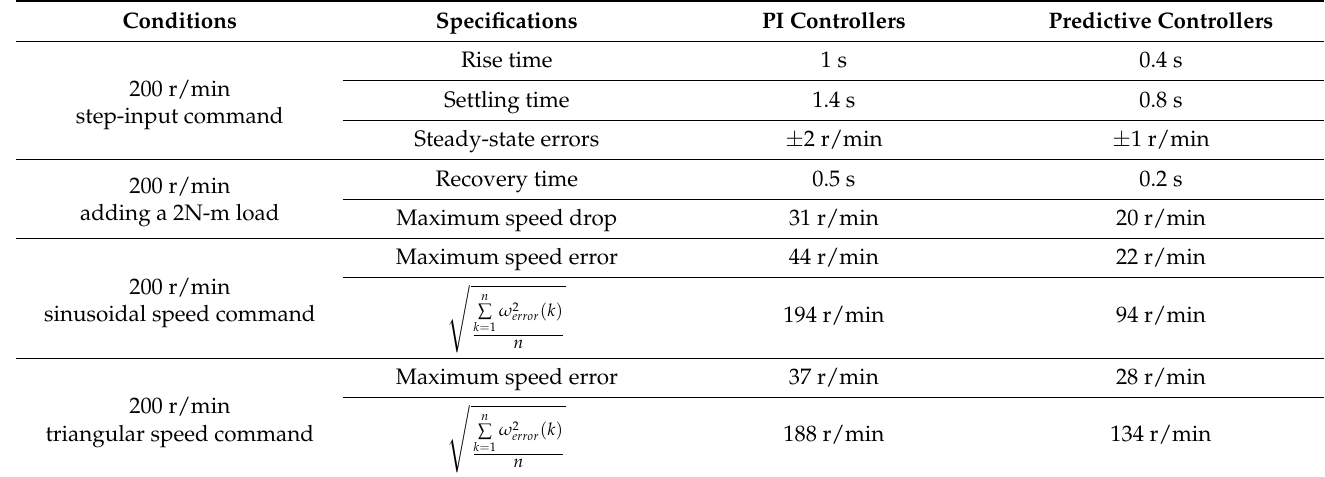
Table 1. Comparisons of predictive controllers and PI